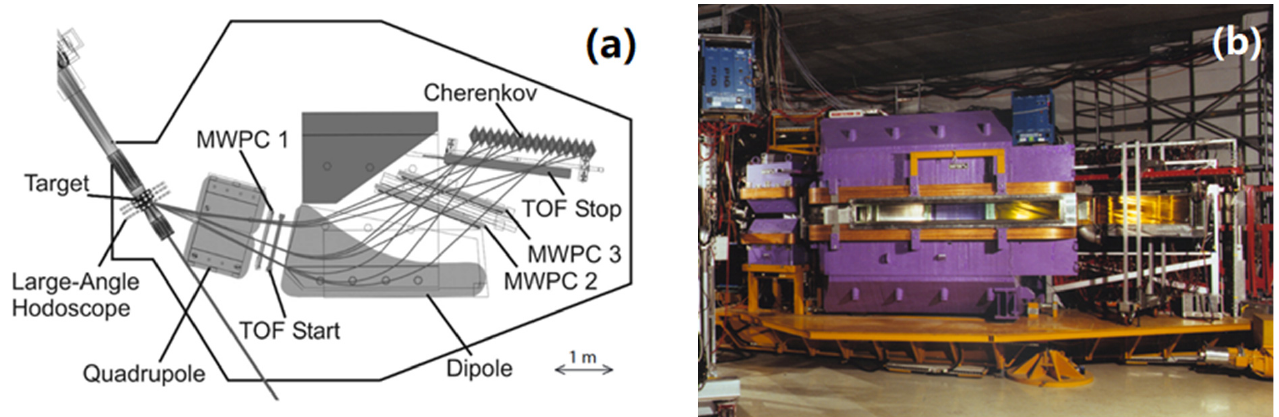
Figure 1. ( a ) Layout of the double-focusing magnetic spectrometer KaoS with its detector system: time-of-flight (TOF) start and stop detectors, 3 multi-wire proportional chambers (MWPC), Cherenkov detectors with water, lucite and silica aerogel radiators, two hodoscopes for event characterization at target (for large angles) and 7 m downstream the target (for small angles, not shown) [32]. ( b ) Photo of the setup.